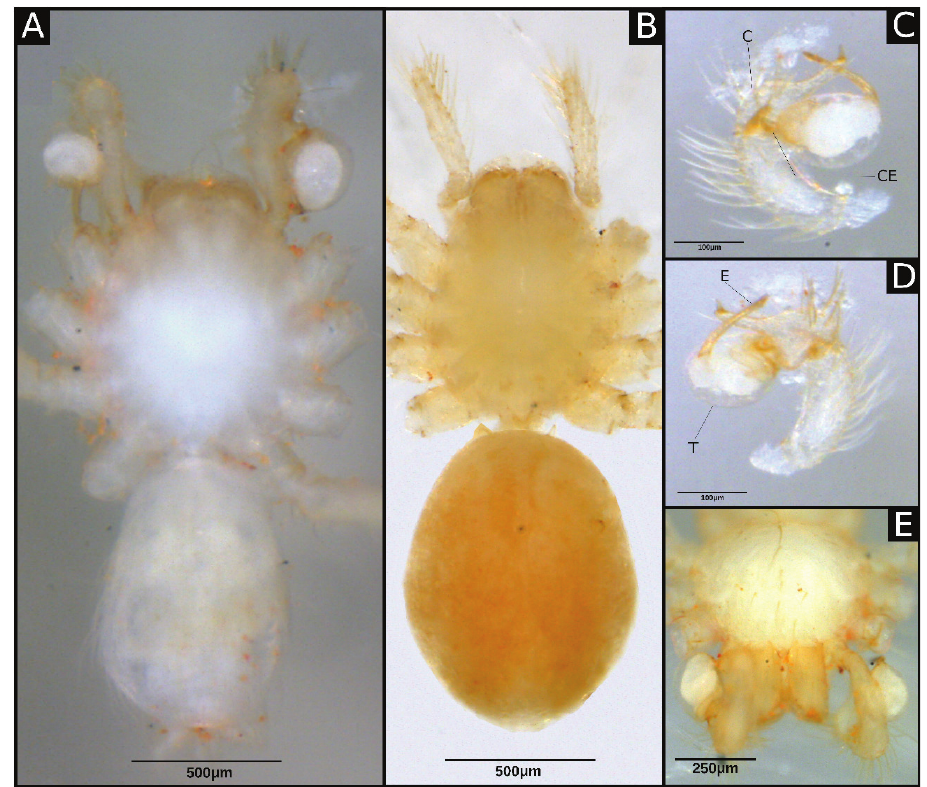
Figure 1. Ochyrocera dorinha sp. nov., male (IBSP 196433) A habitus, dorsal view B female (IBSP 196433), habitus, dorsal view C left male palp (IBSP 196433) prolateral view D same, retrolateral view E carapace, dorsal view. Abbreviations: C, cymbium; CE, cymbial extension; E, embolus; T,